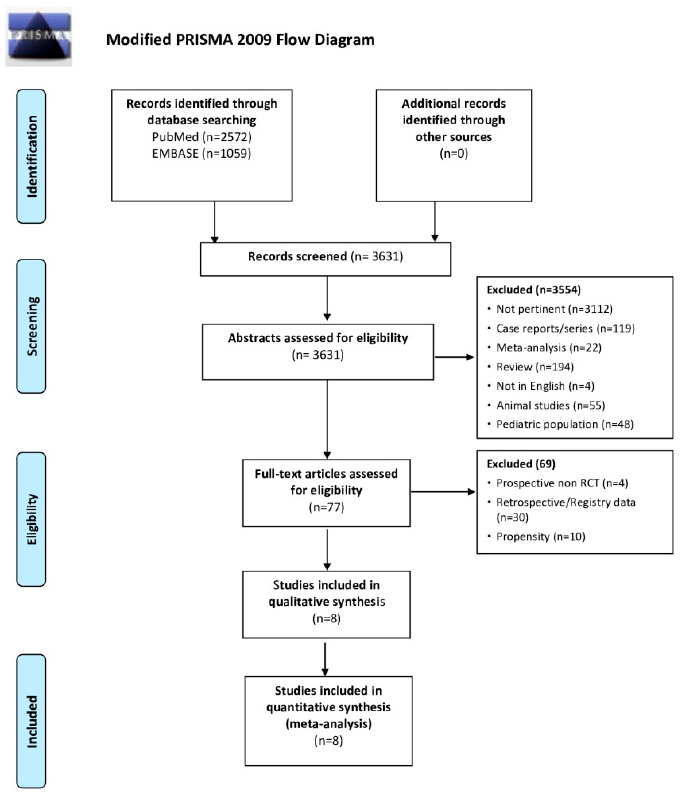
Figure 1. PRISMA flowchart. Table 2. Summary of the included studies of the meta-analysis.